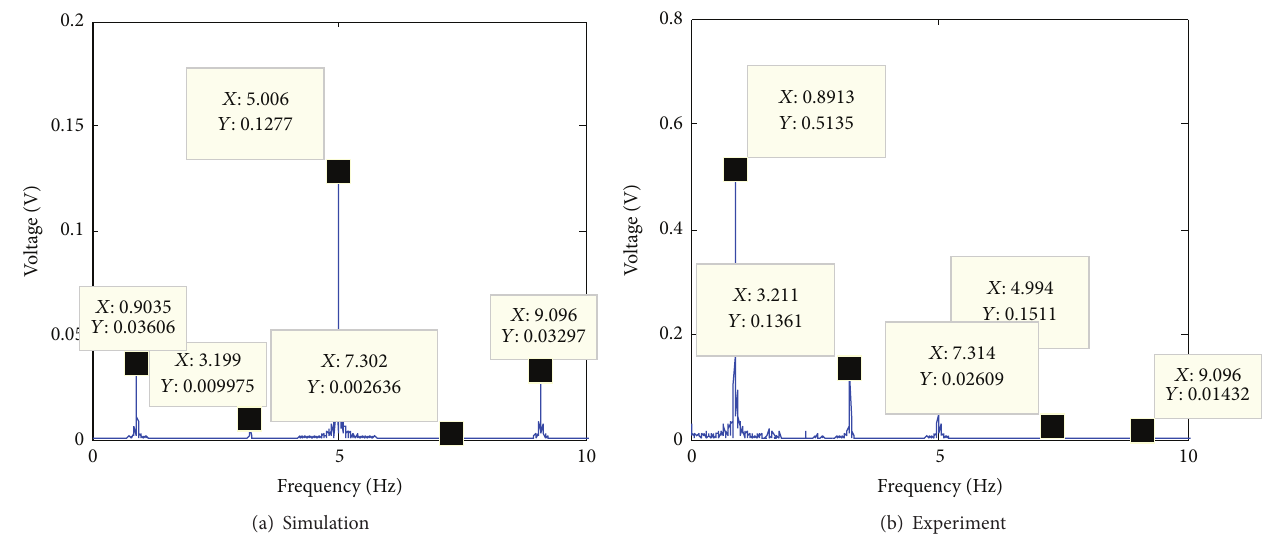
Figure 11: Frequency response at 5Hz.